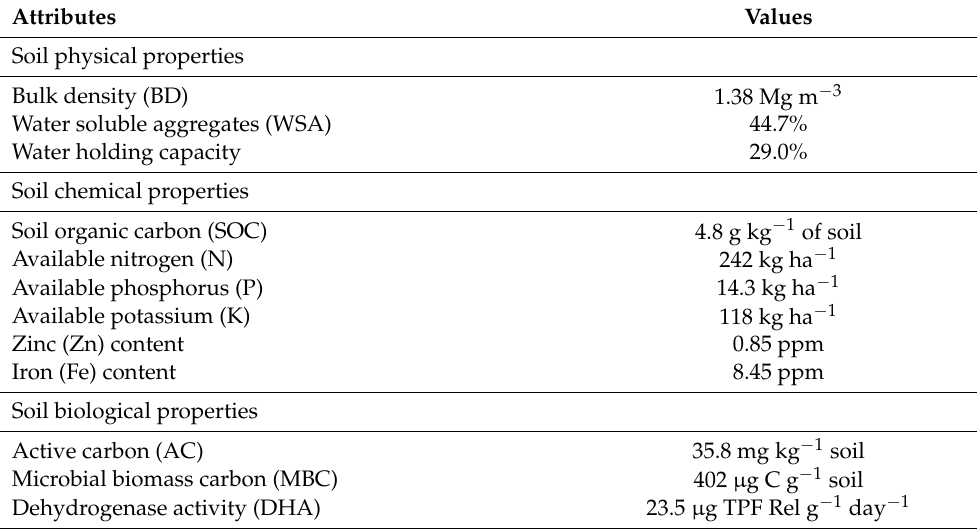
Table 1. The initial status of the soil properties (at 0–15 cm depth) of the study site before sowing the rainy season maize during